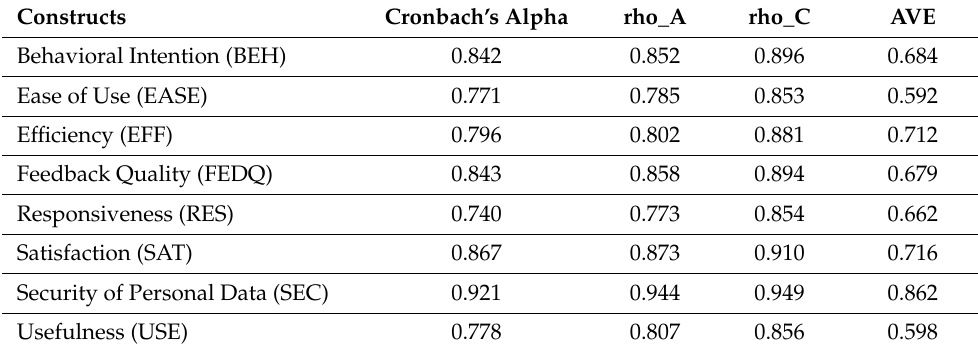
Table 2. Convergent validity and internal consistency of constructs.